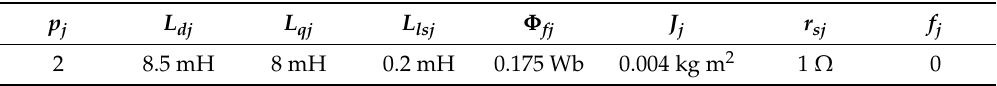
Table 1. Five-phase PMSM parameters.